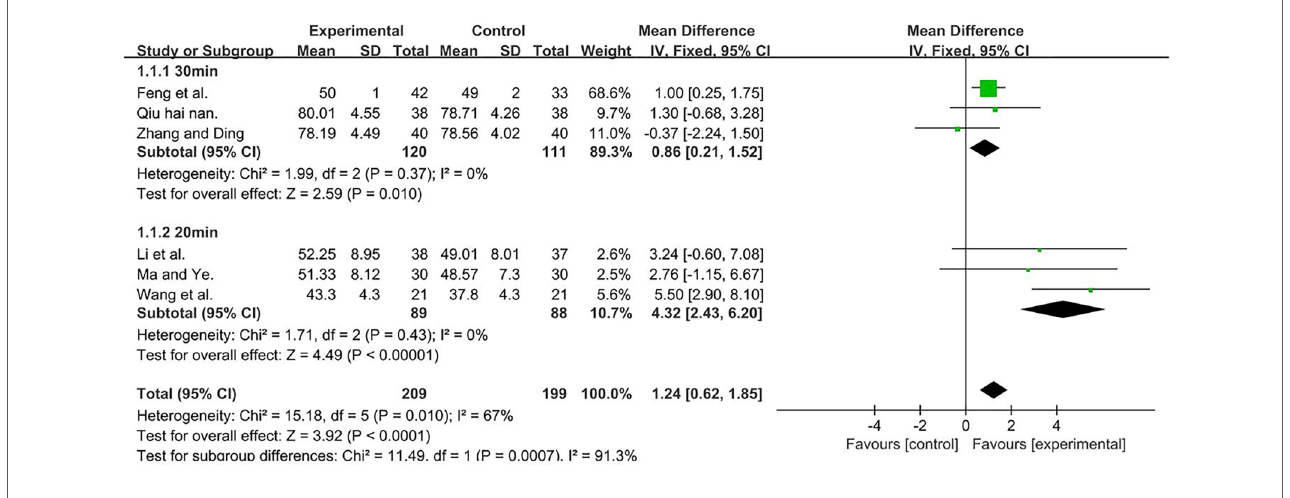
FIGURE 4 Forest plot showing MD (with 95% CI) for GMFM-A of the included studies comparing the experimental and control groups. Note: For the 30 min subgroup, P =0.37 and I 2 =0%, fi xed-effect model [MD=0.86, 95% CI (0.21, 1.52); P =0.01]. For the 20 min subgroup, P =0.43 and I 2 =0%, fi xed-effect model [MD=4.32; 95% CI (2.43, 6.20); P <0.001]. The analysis results of both subgroups were statistically signi fi cant.